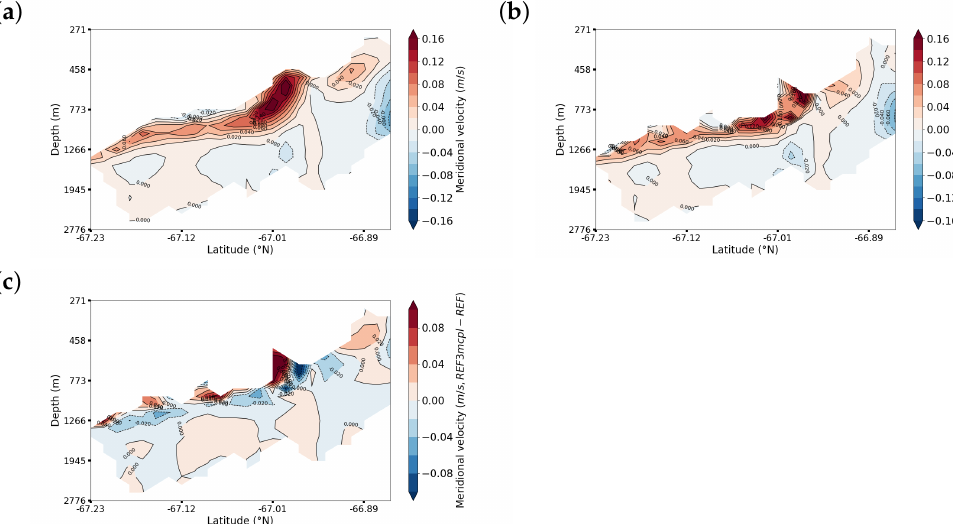
Figure A4. Cross-sections in the TIS cavity of ocean meridional current speed for REF3mcpl ( a ) and REF ( b ), and of ocean meridional current speed difference between REF3mcpl and REF ( c ). All averaged over the 20-year